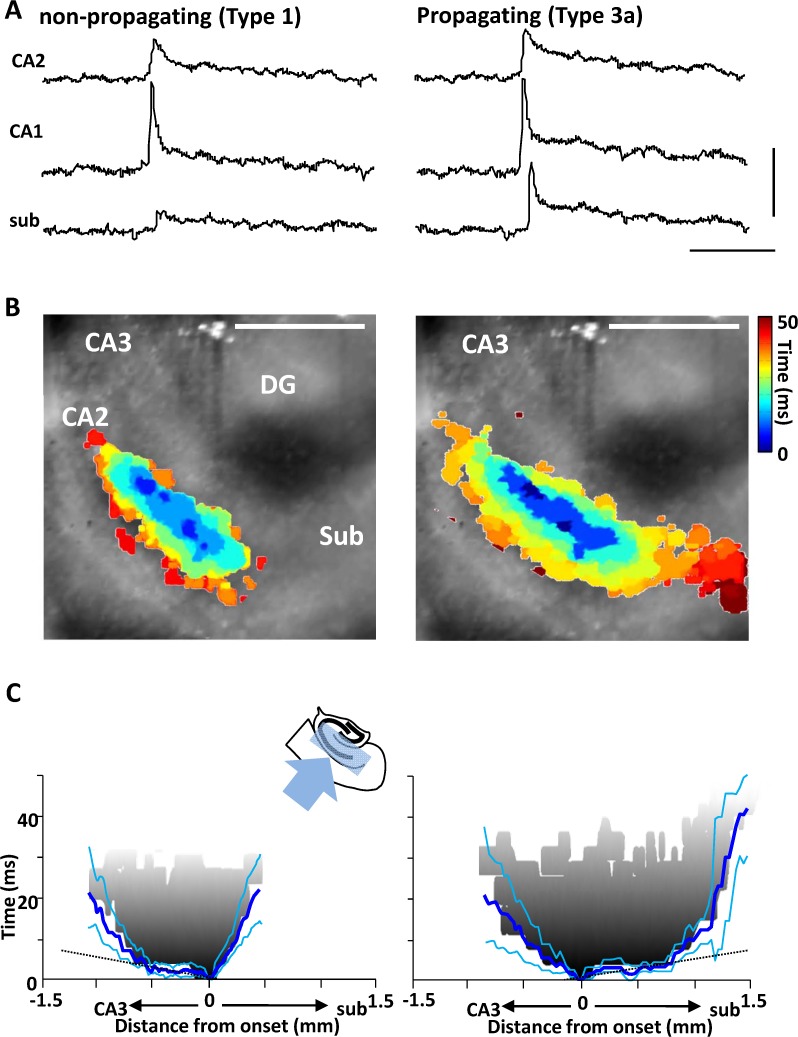
Spatiotemporal properties of non-propagating vs. propagating events originating in hippocampus.
A. Example interictal fluorescence changes along the CA axis for non-propagating and propagating events. Not both types of event originate in CA1 (towards the CA2 border), both types propagate retrogradely into CA3, but only propagating events successfully invade subiculum. Scale bar 0.1% Δf, 1 sec. B. Spatiotemporal maps of the two event types in hippocampus. Only areas demonstrating activity over threshold are represented on the colormap, overlaid on the transmitted light (non-fluorescent) slice image. Main areas are labelled DG (dentate gyrus), CA2,3 (cornu ammonis subdivisdion 2,3), Sub (subiculum). Note the activity is concentrated in mid stratum radiatum. Colormap represents time from event onset (cool-hot). C. Mean event onset and spread (n = 6 slices) viewed along the CA1 horizontal axis (as illustrated by the cartoon insert). An individual example of an interictal wavefront (1st threshold crossing) is shown in gray, blue lines show mean ± s.e.mean. Note the mean initial propagation velocity is very rapid along CA1 (slope of wavefront, dotted lines) in opposite directions for the two events, but in each case, velocity slows markedly on reaching CA3 and subiculum (see results for quantification).